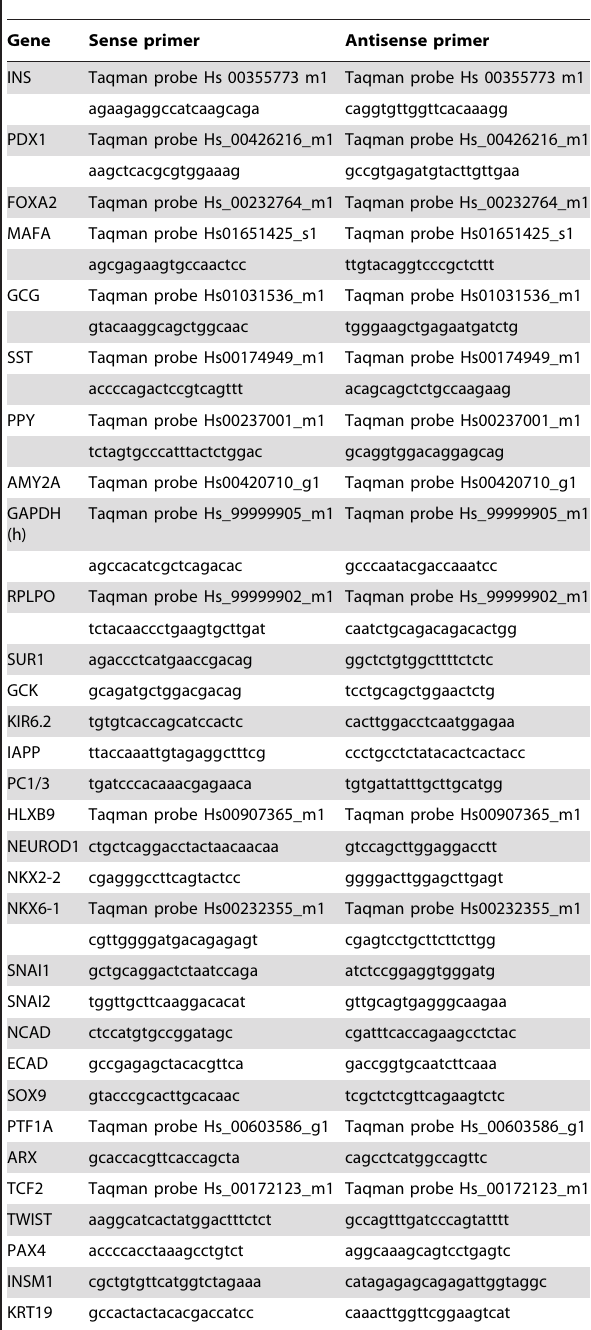
Table 2. Primer sequences.